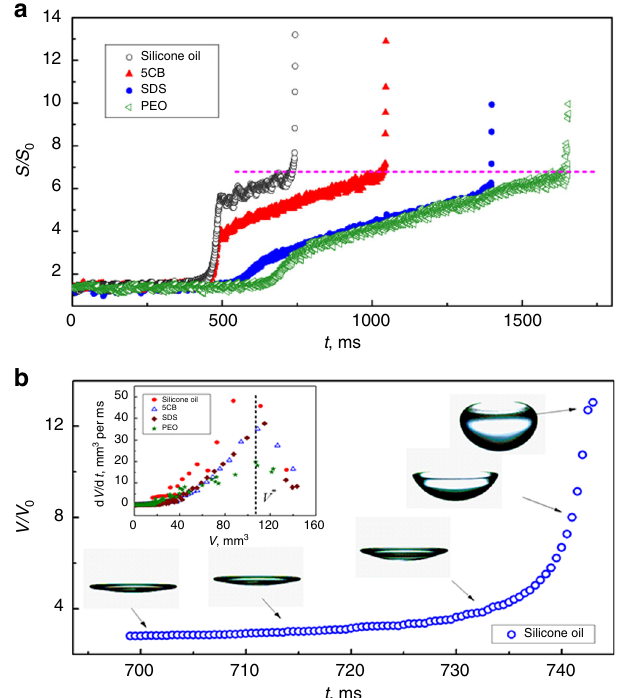
Fig. 3 Surface area variation and cavity in fl ation during bubble formation. The sound intensity was increased at u R = 1.00 mm/s. a Surface area (normalized by the surface area of a spherical drop) variation for drops of different liquids with similar fi ve stage behavior. The abrupt area expansion occurs at different time intervals, i.e. emitter – re fl ector distance, but corresponds to similar surface area marked by the dashed line. b Cavity volume of silicone oil (normalized by the initial drop volume) as a function of time. The inset graph shows that the maximum in fl ation rate, d V /d t , corresponds to the same critical volume V * for all the